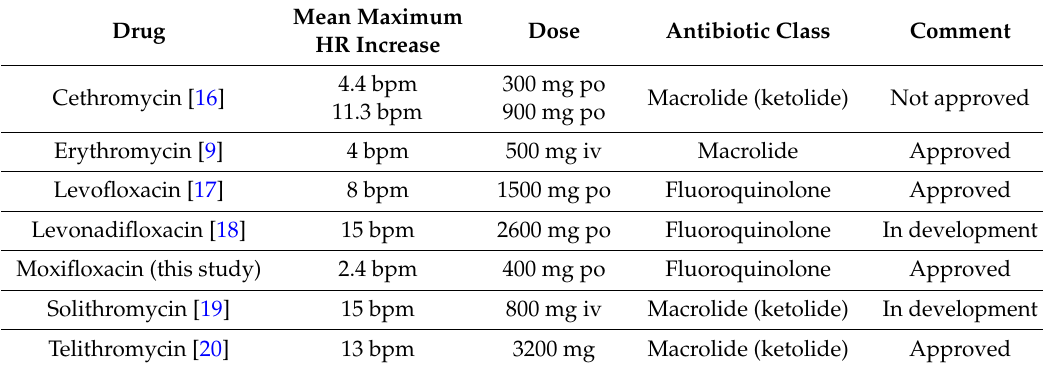
Table 3. Antibiotics that increase heart